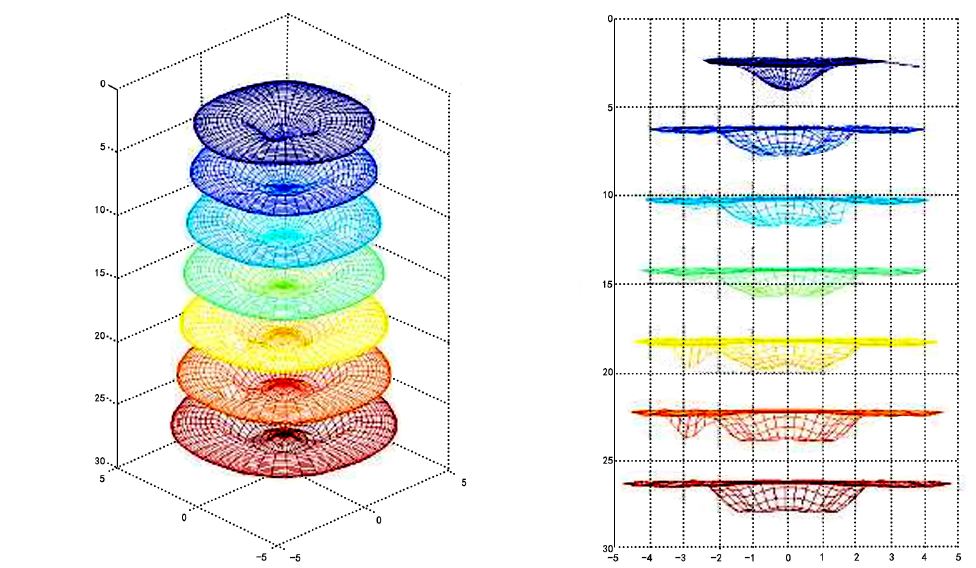
Figure 1. A high-resolution image of the burden